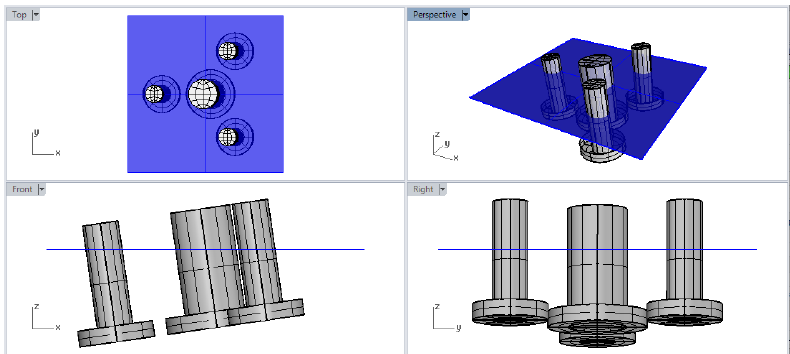
Figure 11. High-order mesh of columns and heave plates—Heeled.